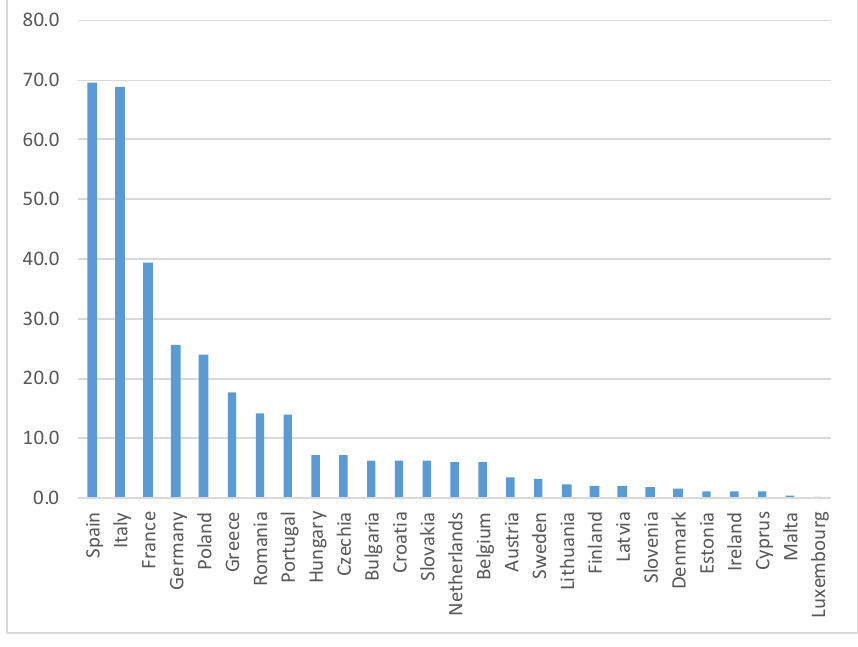
Figure 4. Investments in Recovery and Resilience Plan 2021–2023 (billion euros) by EU country. Source: own elaboration with data from EU member States and the Spanish Recovery Plan